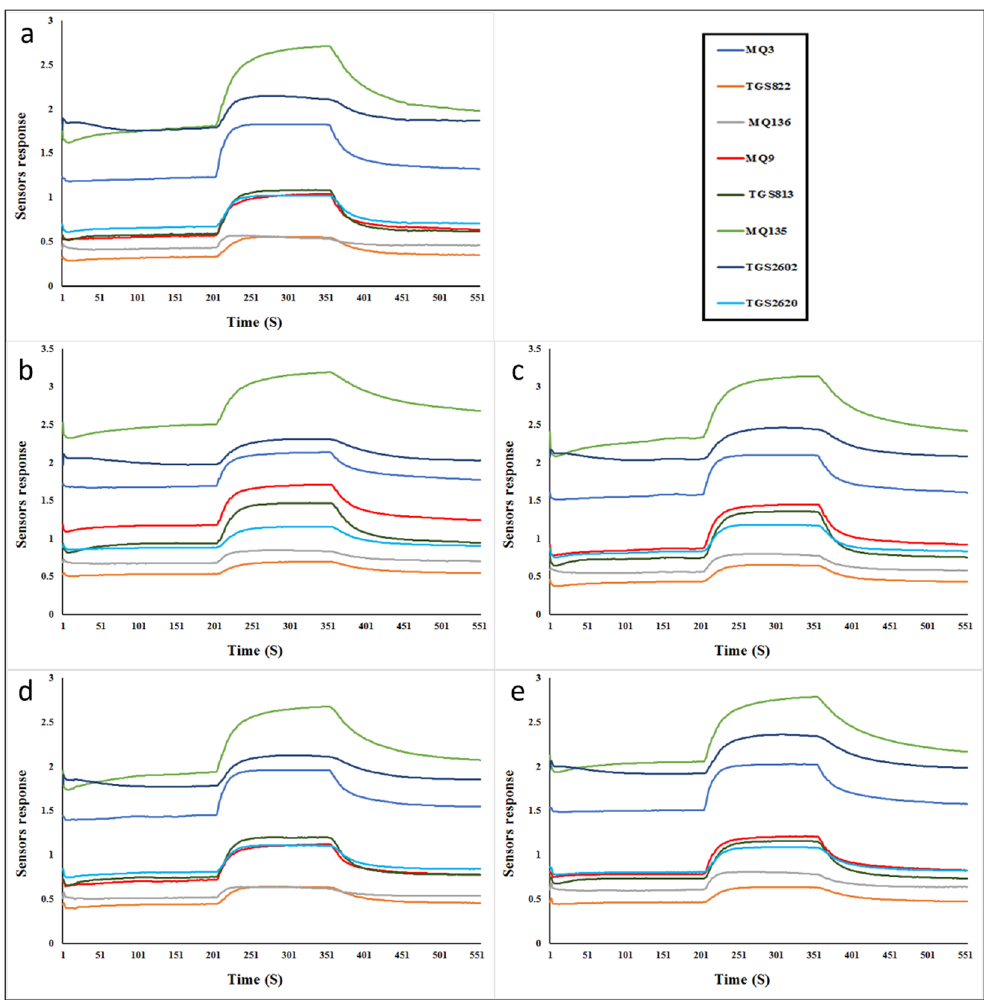
Figure 2. Electronic aroma signature pattern output responses (smellprints) from the 8-MOS ex- perimental e-nose sensor array to the VOC differences in the headspace volatiles detected from cucumber fruits harvested from plants receiving different levels of urea fertilizer. E-nose output data derived from fruits of cucumber plants receiving the following equivalent application rates of urea at ( a ) 0 kg/ha (no urea), ( b ) 100 kg/ha, ( c ) 200 kg/ha, ( d ) 300 kg/ha, and ( e ) 400 kg/ha. All eight sensors produced measurable responses when exposed to aroma VOC emis- sions from all five of the cucumber fruit sample types. When examining the differences in the smellprint signatures produced from different treatments, the sensor intensity responses of each sample type generally were compared using the relative position of the sensor inten- sity responses to the different sample types for each individual sensor. These comparisons are based on the highest intensity response reached by each sensor during the analytical runs. Notice that the relative order of magnitude (of the sensor intensity responses) to the majority of the urea application rate treatments (100, 200, and 400 kg/ha) followed the sensor intensity order (top to bottom, with the curve color indicated) of sensor 6 (MQ135, light green), sensor 7 (TGS2602, dark blue), sensor 1 (MQ3, medium blue), sensor 4 (MQ9, red), sensor 5 (TGS813, dark green), sensor 8 (TGS2620, cyan), sensor 3 (MQ136, gray), and sensor 2 (TGS822, orange). This predominant 6–7–1–4–5–8–3–2